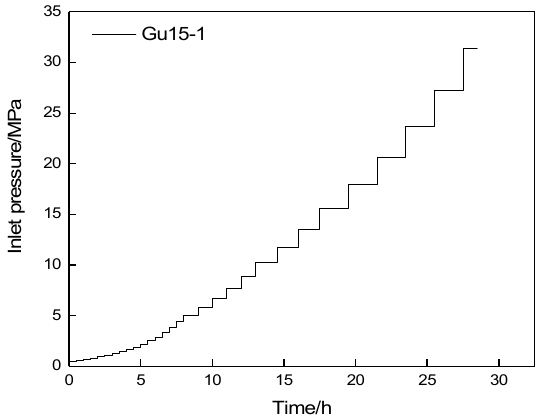
Figure 10. Inlet pressure loading curve and time (Gu15-1).